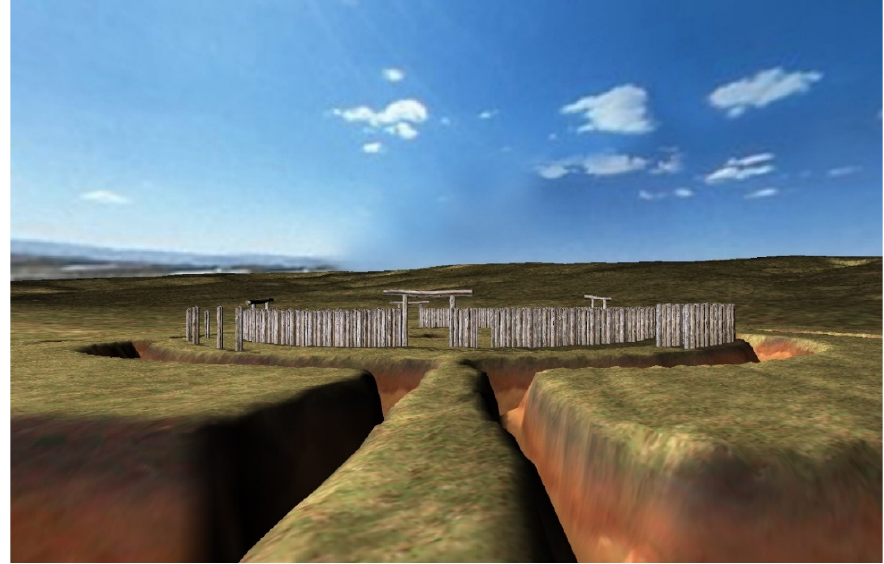
Figure 3. Virtual reconstruction of the KGA at Steinabrunn ([2] Figure 3.2.1_01).